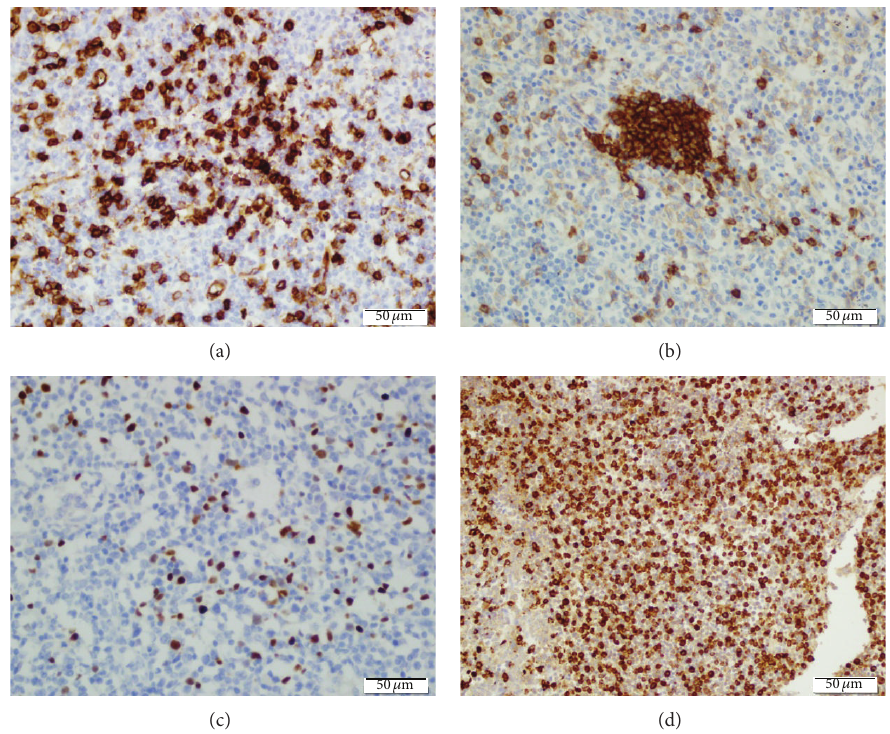
Figure 4: Polymorphic abnormal cells positively stained with A-CD34x40, B-C117x40, C-Tdtx40, and D-MPOx40.